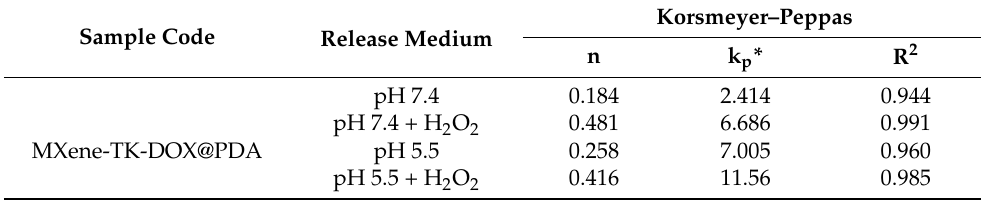
Table 1. In vitro doxorubicin release kinetics data based on the Korsmeyer–Peppas model. Sample